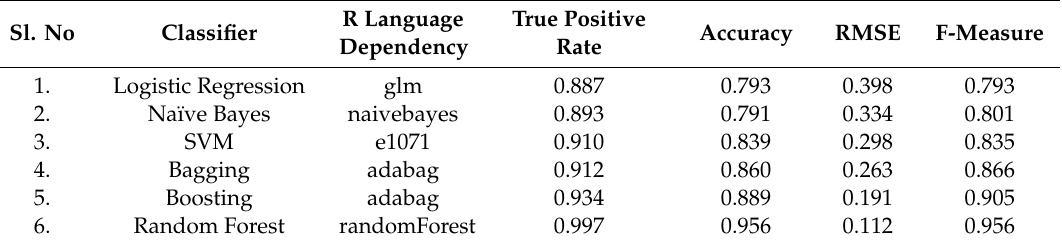
Table 3. The performance of models in initial phase of churn detection.